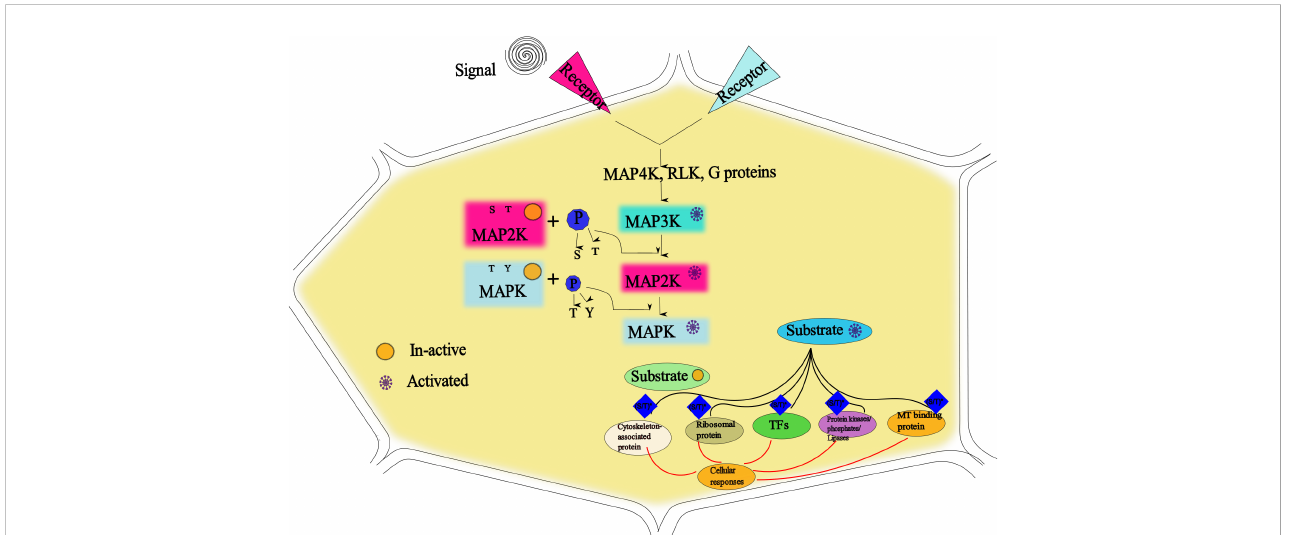
FIGURE 2 The receptors after receiving the signals activate the speci fi c mitogen-activated protein kinase (MAPK) proteins that are inactive before. Subsequently, MAP4K activates other MAPKs (including MAP2K and MAP3K) by phosphorylating the ST (S/T is serine/threonine) and TXY (T is threonine, Y is tyrosine, and X is any amino acid) motif in MAPKs (Rodriguez et al., 2010; Taj et al., 2010). As a result, MAPKs activate the transcription factors (TFs), enzymes, and other downstream kinases that transmit extracellular environmental signals to the cells that play a role in growth, development, stress response, and other physiological and biochemical processes (Zhang et al., 2018).